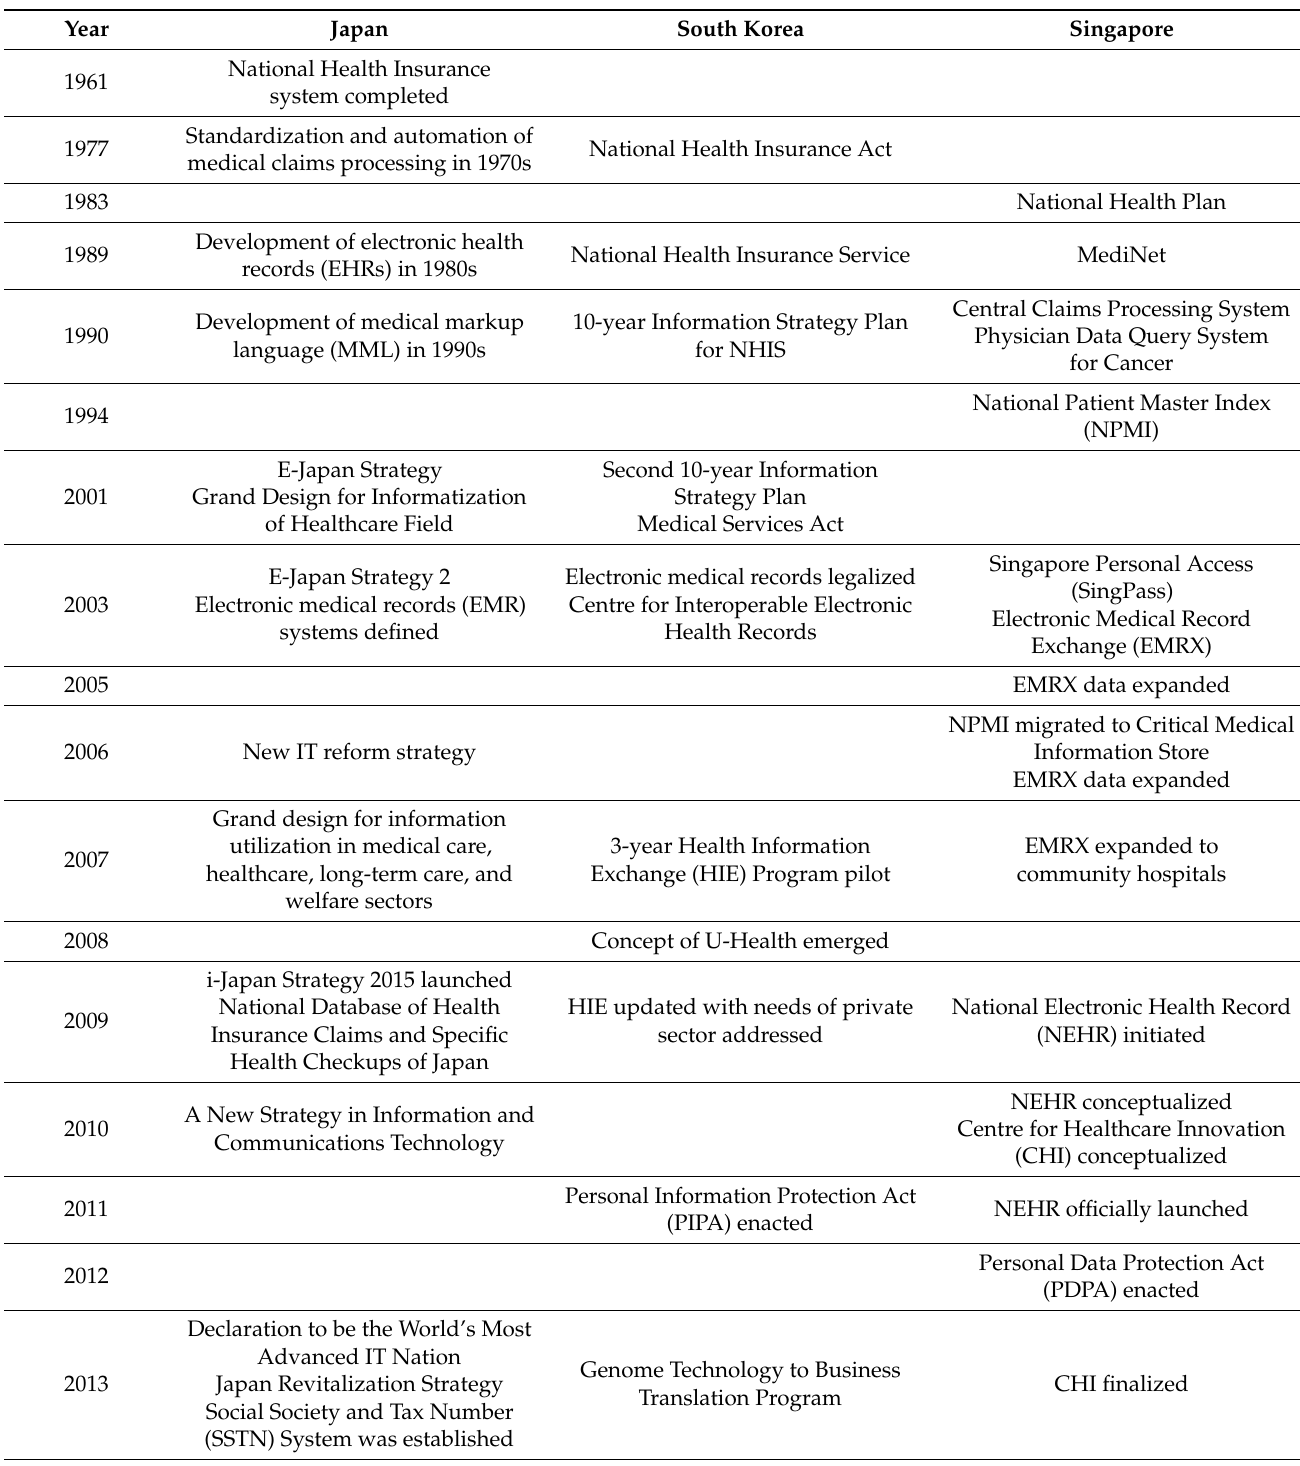
Table 1. Timeline of cloud adoption and healthcare innovations across the three